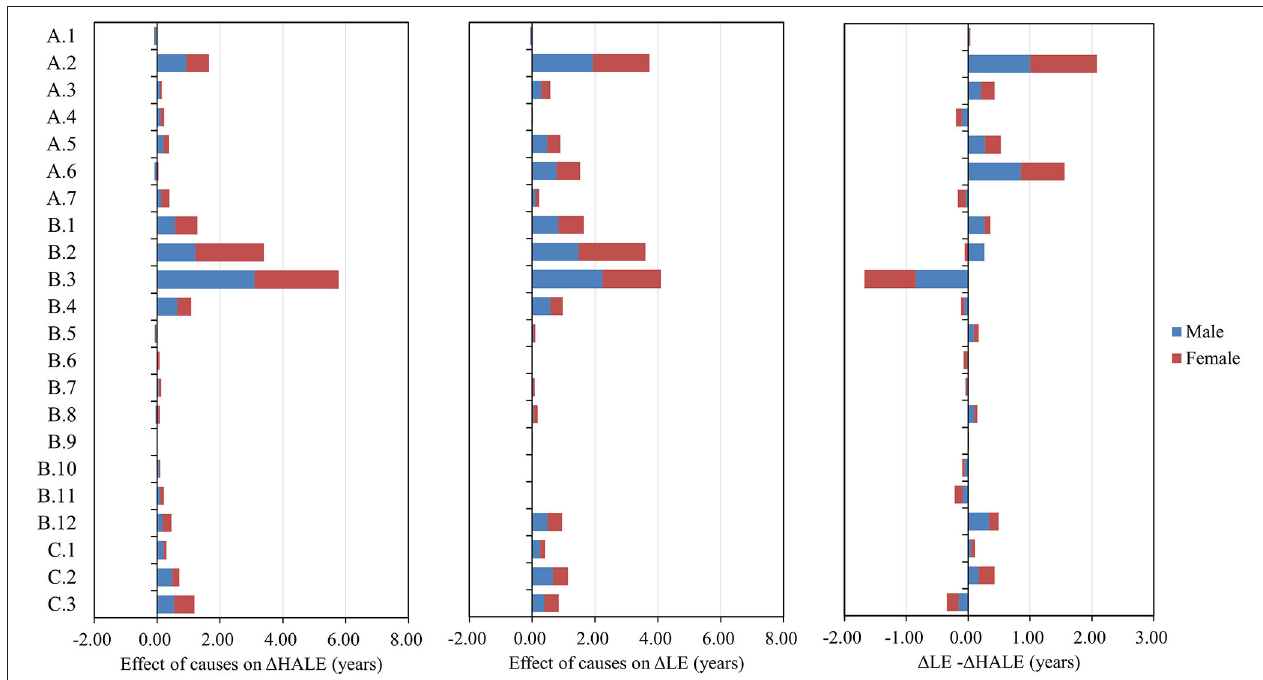
FIGURE 3 | Cause-specific effects on changes in life expectancy (LE) and health-adjusted life expectancy (HALE) (levels 1–2) for males and females from 1990 to 2019.